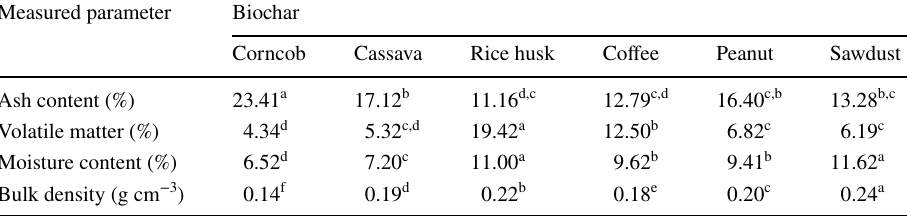
Table 3 Ash, volatile matter and moisture content of biochar issued from crop wastes